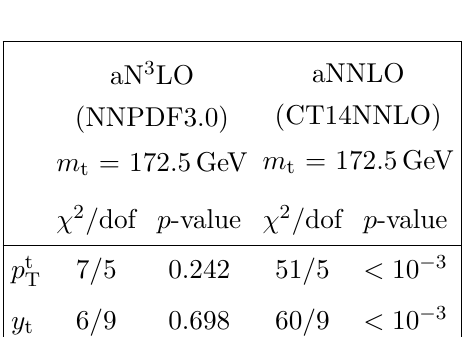
Table 50 . The (cid:31) 2 /dof and p -values quantifying the agreement between the two theoretical predic- tions with aN 3 LO and aNNLO precision and the measured, parton-level normalised cross sections are